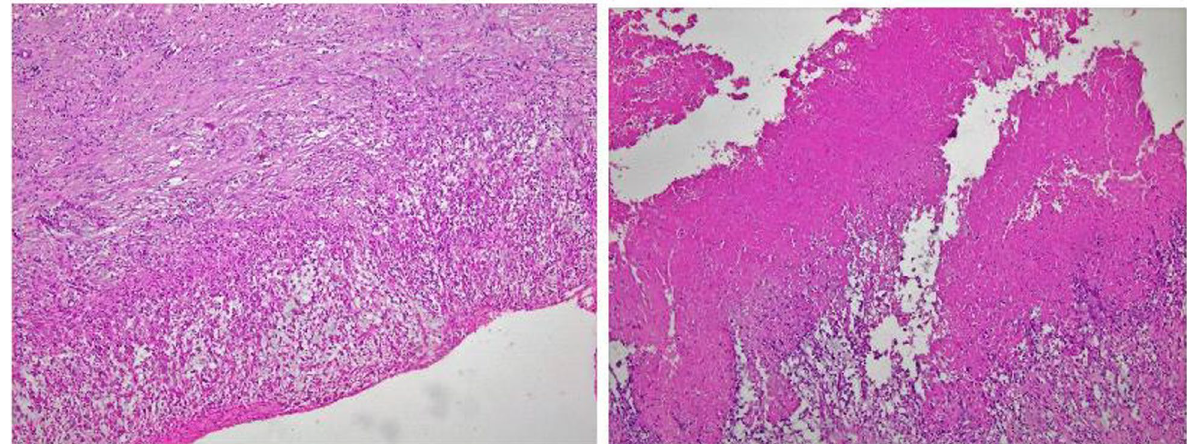
Fig. 3 Histopathological images with fibrin rich leukocytic material adherent to cardiac wall suggesting intracardiac thrombus (standard coloration H&E on light